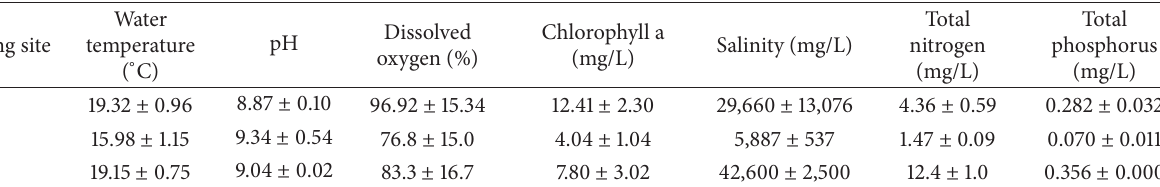
Table 2: Mean ± SD values of the principal water quality characteristics across the three sampling sites within the lake: Gesuer (GSE), Hekou (HK), and Xiaohaizi (XHZ) ( 𝑛 = 11 ).